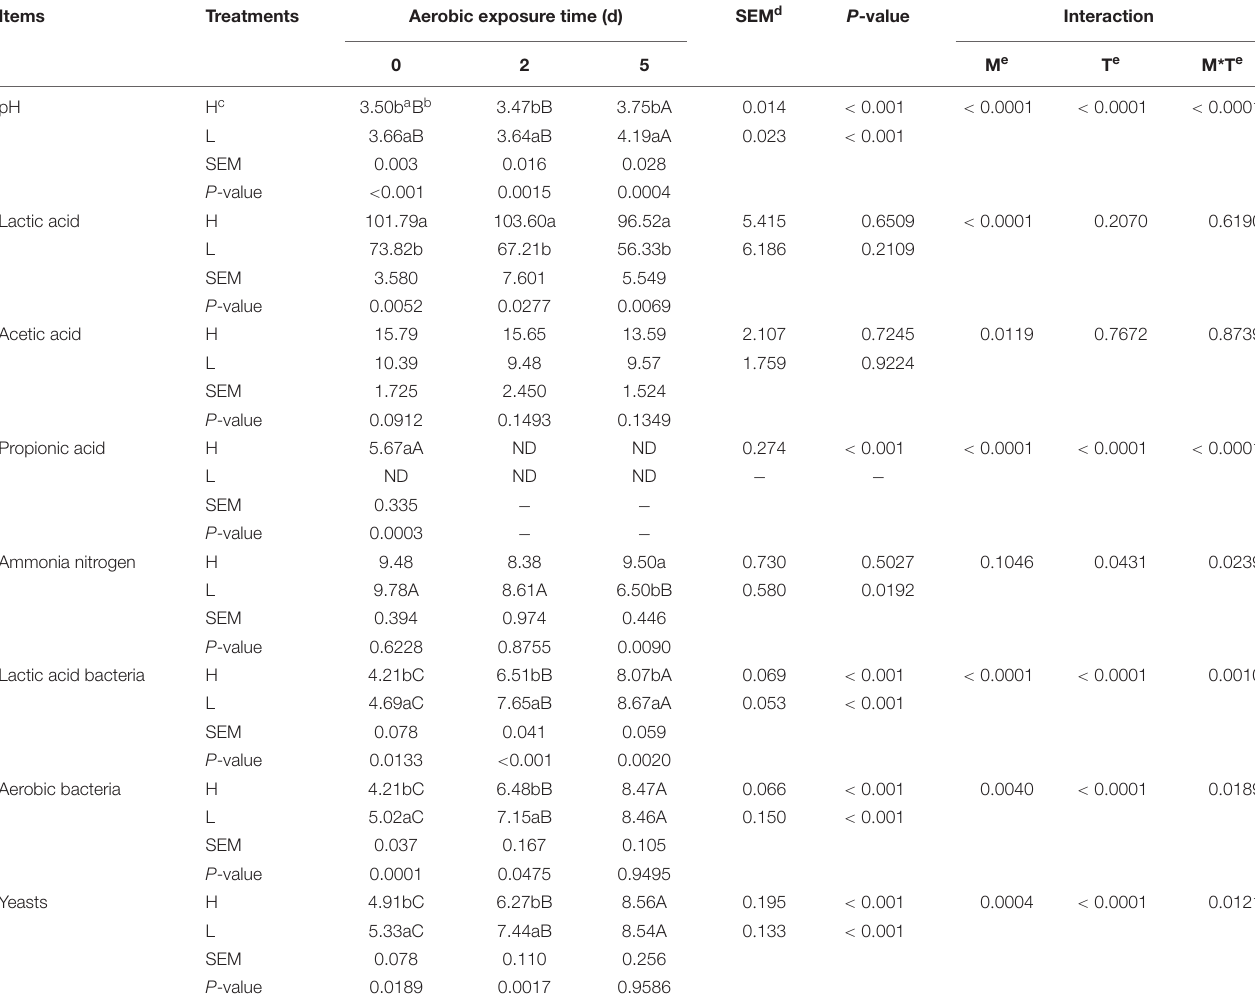
TABLE 1 | pH, organic acid content (g/kg dry matter), ammonia nitrogen content (AN, g/kg total nitrogen), and microbial counts (log 10 colony forming units/g fresh weight) of whole-plant corn silage during aerobic exposure. Items Treatments